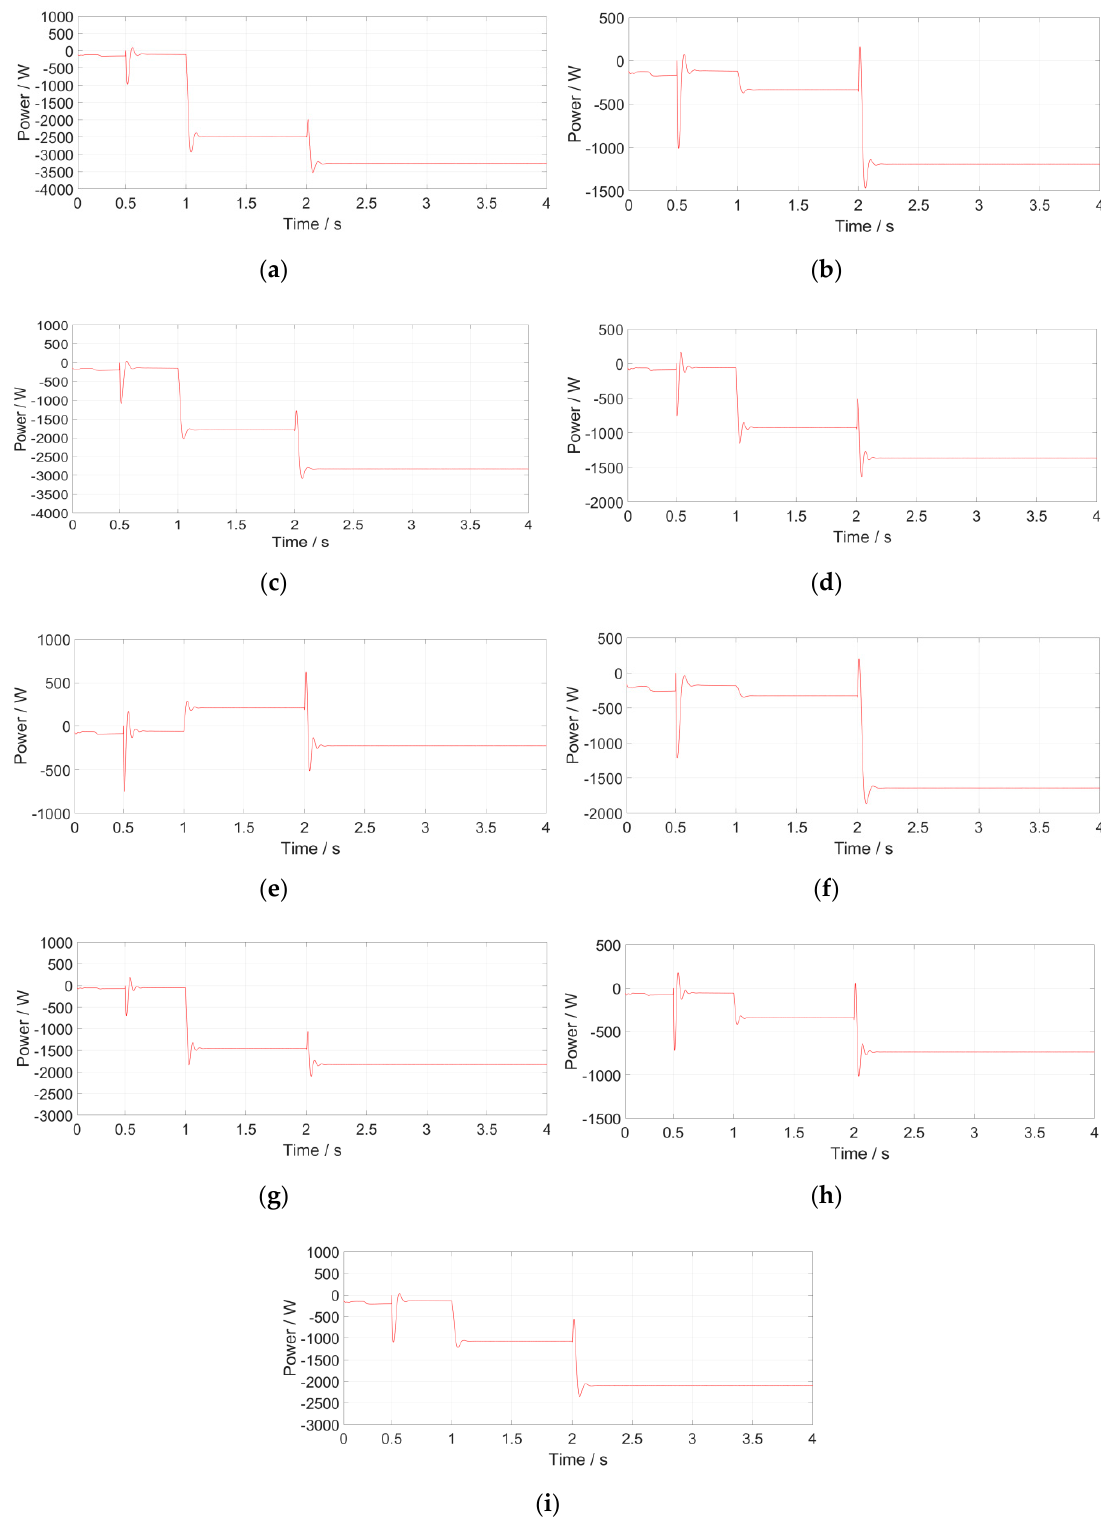
Figure 8. Charging power of EV i,j in the group of: ( a ) SoCi.class = 1,AVDTi.class = 1; ( b ) SoCi.class = Figure